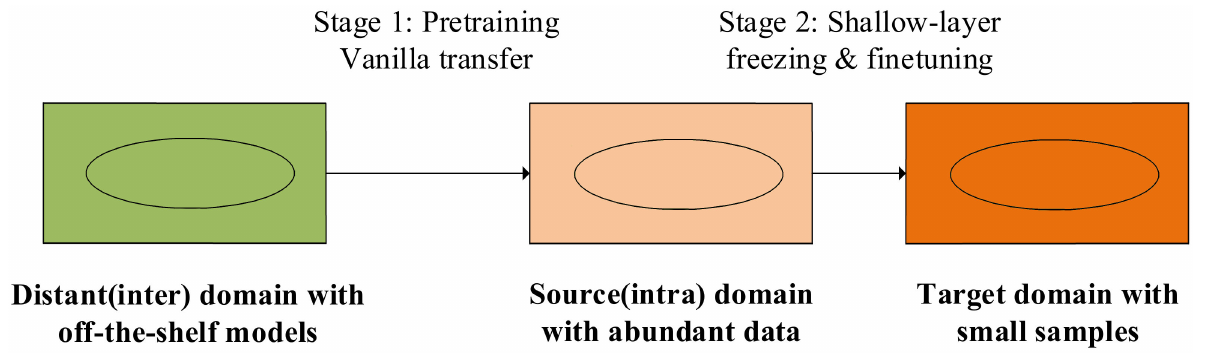
Figure 2. Illustration of the intra-domain transfer learning